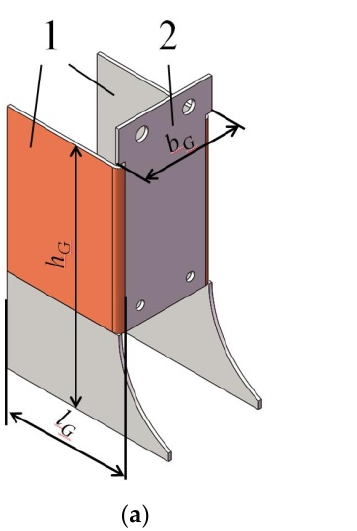
Figure 4. Critical parameters of the RSM. ( a ) Oblique view; ( b ) top view. Note: 1, side baffle; 2, seed strip baffle. b G is the width of the RSM, mm; h G is the height of the RSM, mm; l G is the length of the side baffle, mm; θ is the included angle between the strip baffle and the side baffle.